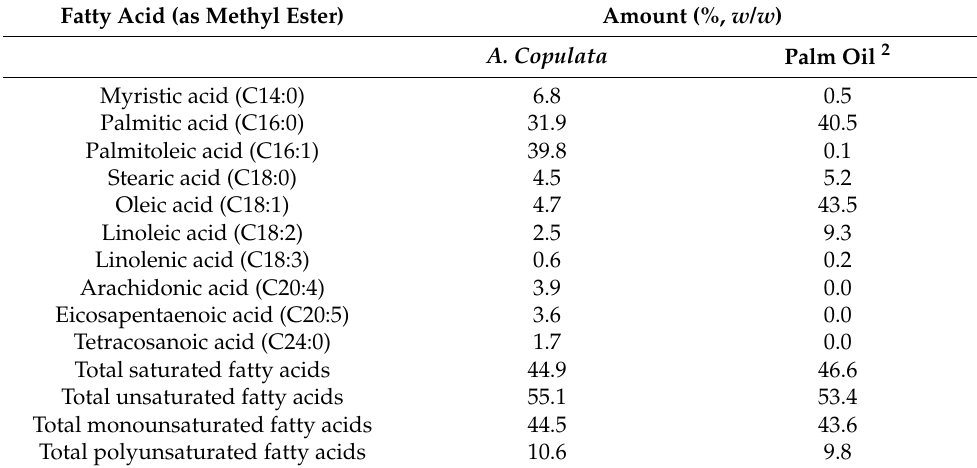
Table 4. Fatty acids profiles of Amphora copulata 1 and palm